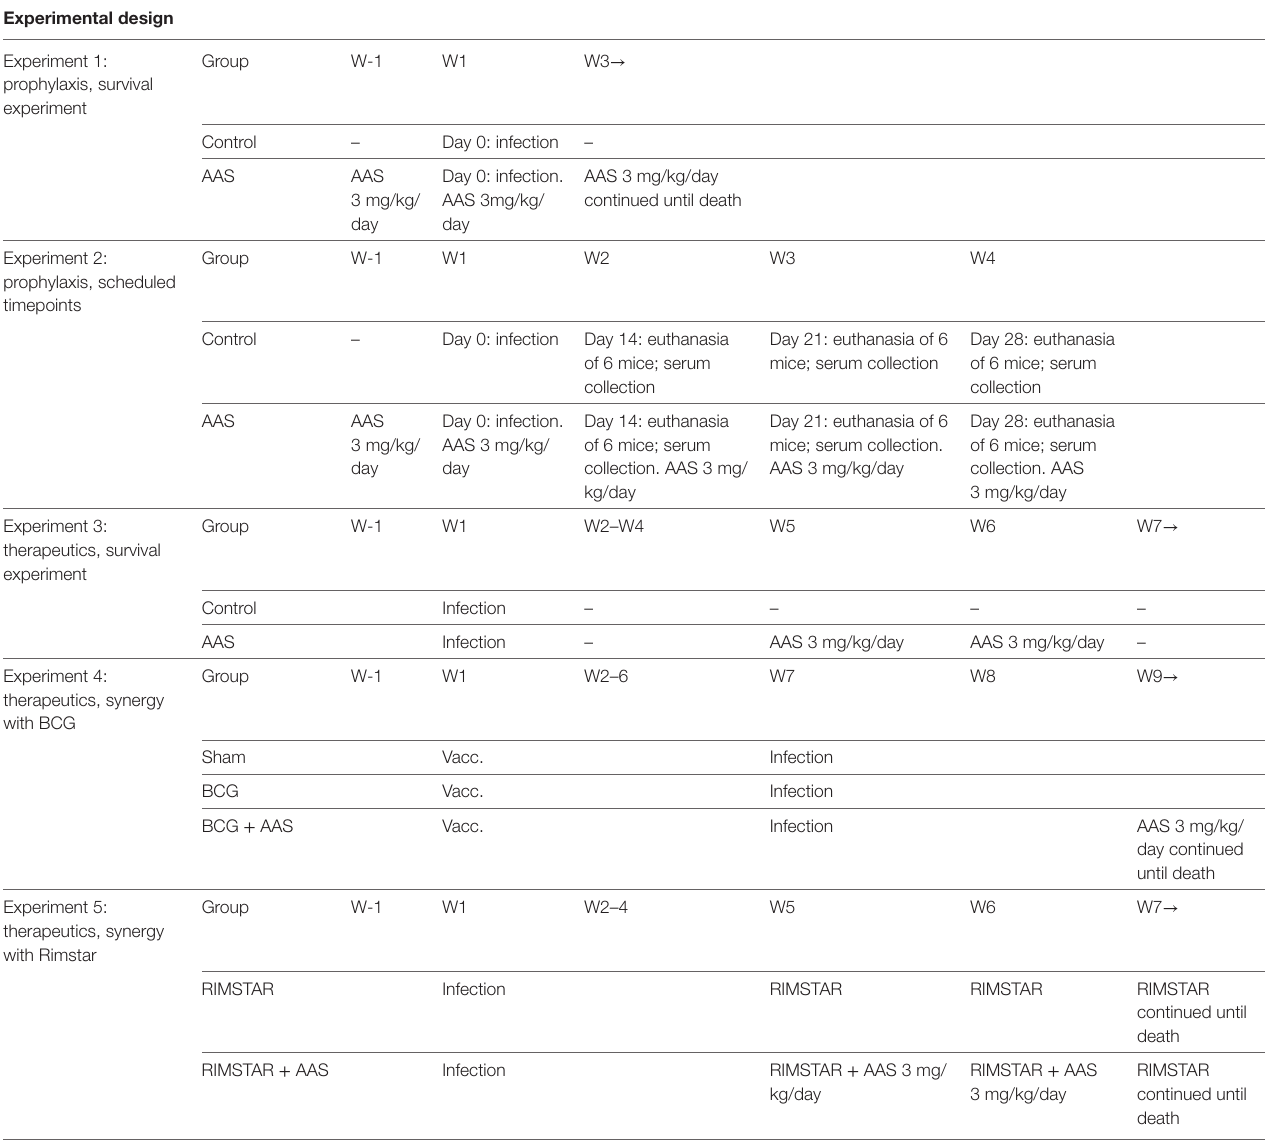
TaBle 1 | Experimental design of the five experiments included in the study. experimental